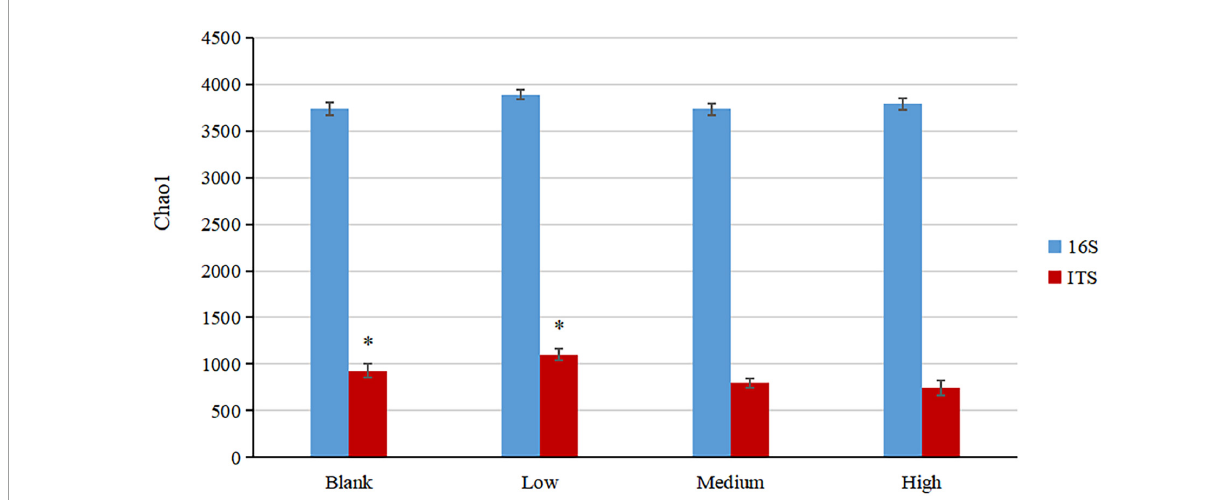
FIGURE3 Soil microbial diversity index under different radiation intensities. ∗ P < 0.05.